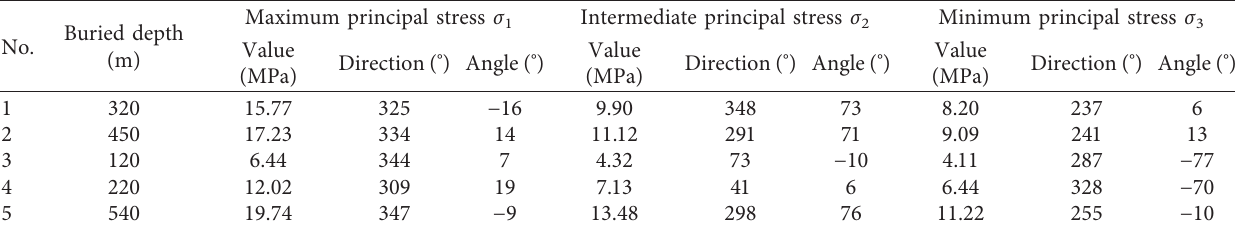
Table 7: Calculation results of principal stress at each measuring point.